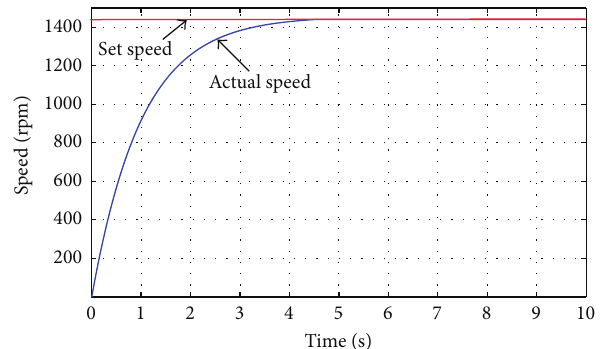
Figure 12: Simulated speed response of three-phase IM drive at no load and rated speed.